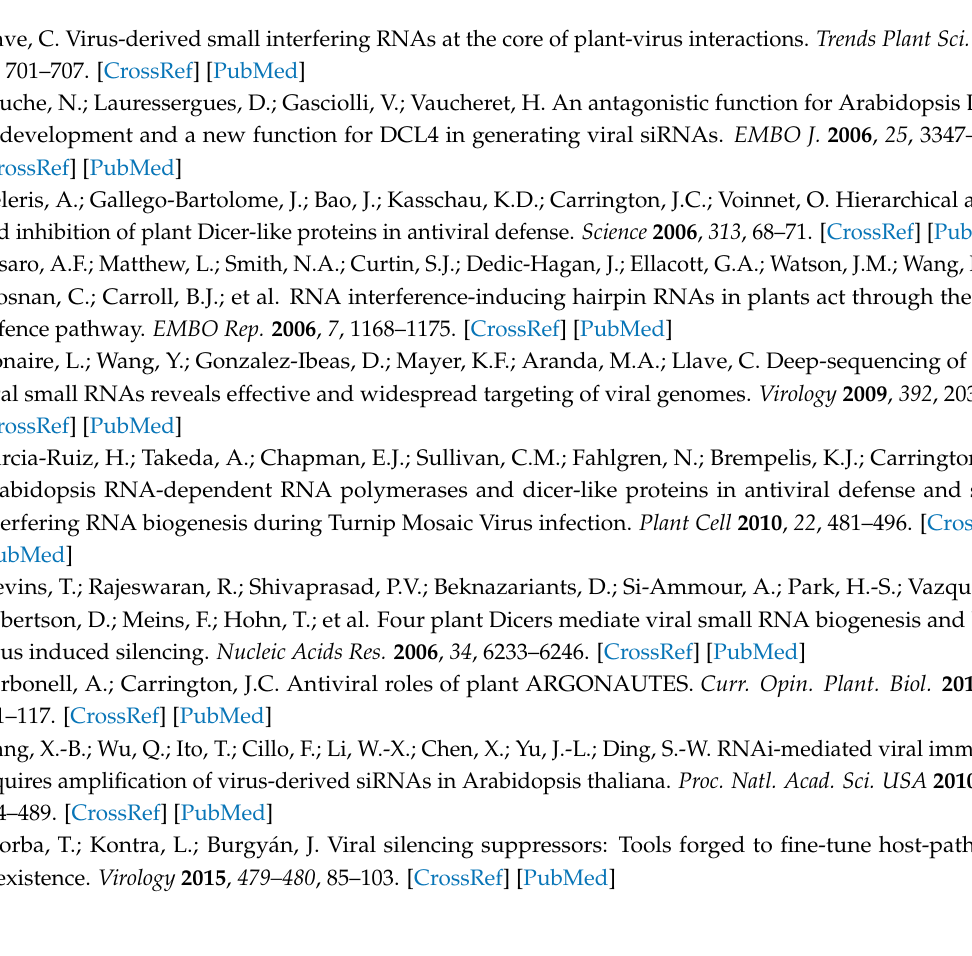
Figure S1: Phylogenetic analysis of Luteovirus P6 proteins and luteovirid P4 proteins, Figure S2: Local systemic silencing assay with BYDV-PAV proteins P4 and